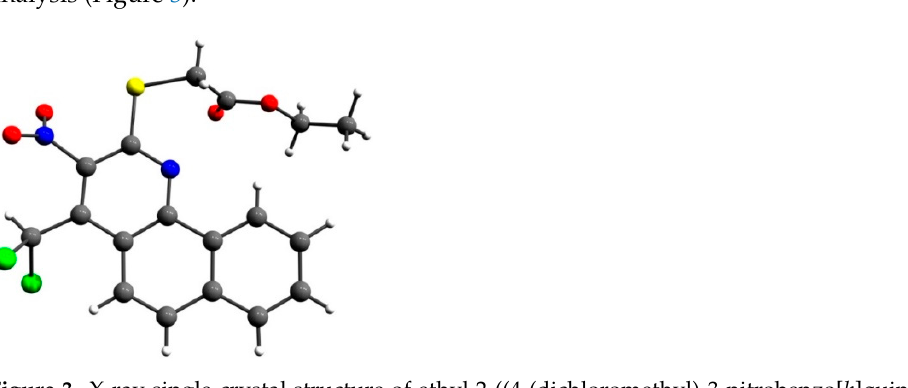
Figure 3. X-ray single-crystal structure of ethyl 2-((4-(dichloromethyl)-3-nitrobenzo[ h ]quinolin-2- yl)thio)acetate ( 5a